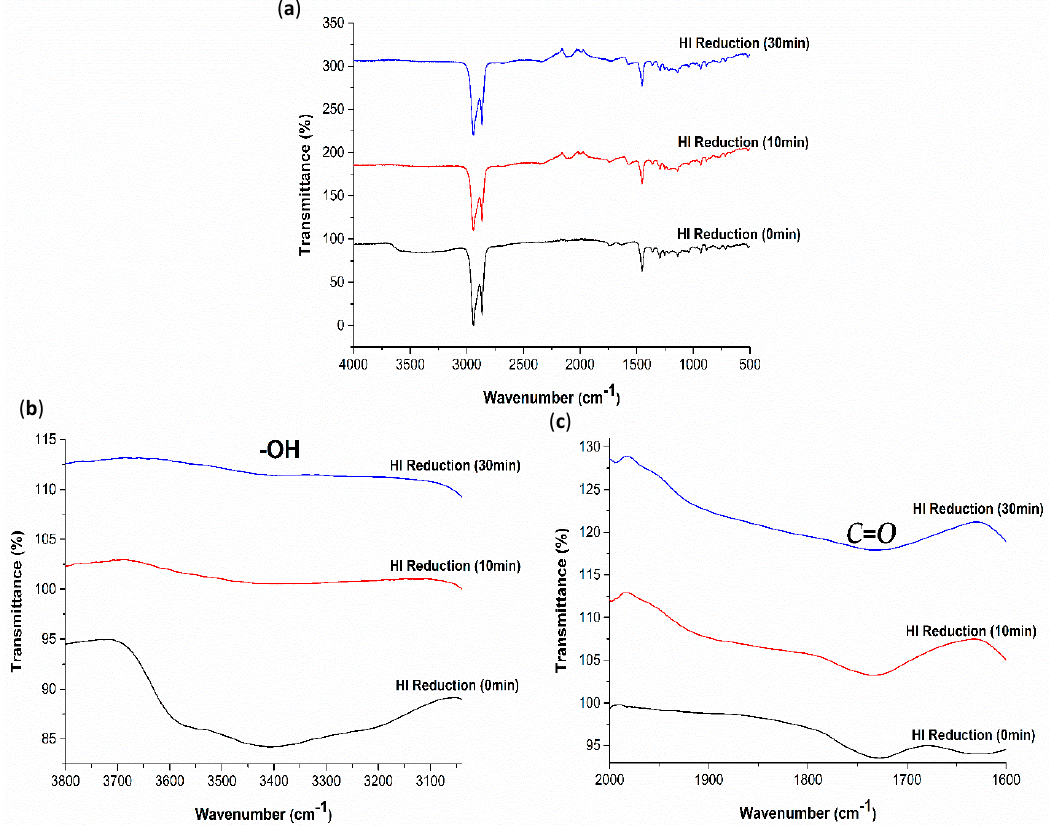
Figure 13. ( a ) FTIR − ATR spectra for 4 mg/mL GO − coated COC treated with HI for different durations and expanded regions of FTIR − ATR spectra between ( b ) 3050 − 3800 cm − 1 and ( c ) 1500 − 2000 cm − 1 .